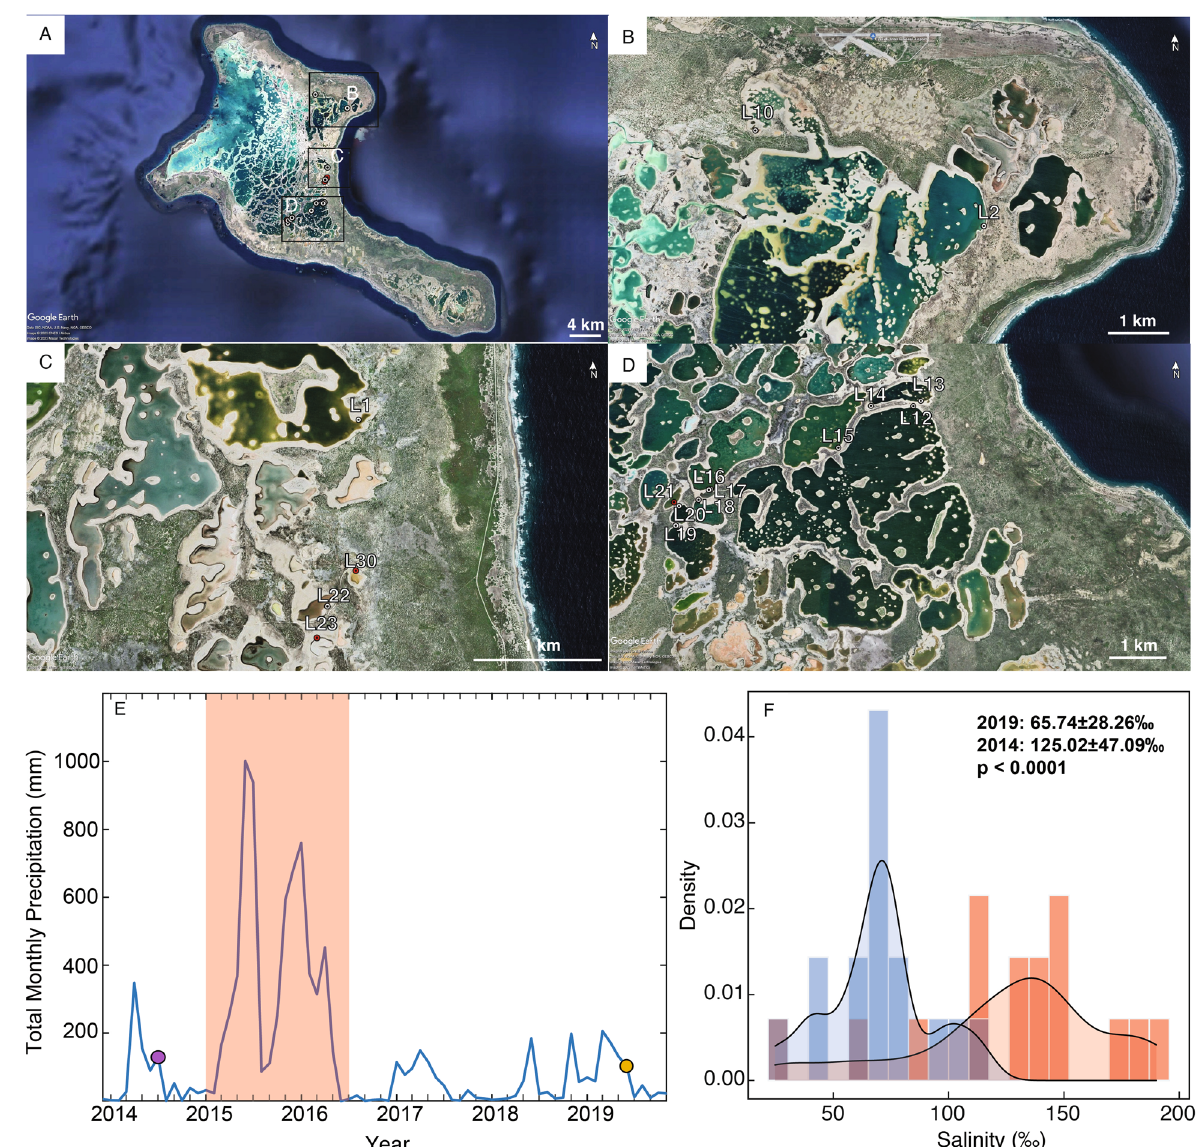
Figure 1. ( A ) Map of Kiritimati (Google Earth, 2021) indicating ( B – D ) locations of sample sites. Samples collected in both 2014 and 2019 are denoted by white circles, and samples only collected in 2019 are denoted by red circles. ( E ) Total monthly precipitation from the Kiritimati weather station. Markers indicate 2014 and 2019 field seasons. ( F ) Histogram of lake salinity variations from collected 2014 (red) and 2019 (blue) lake